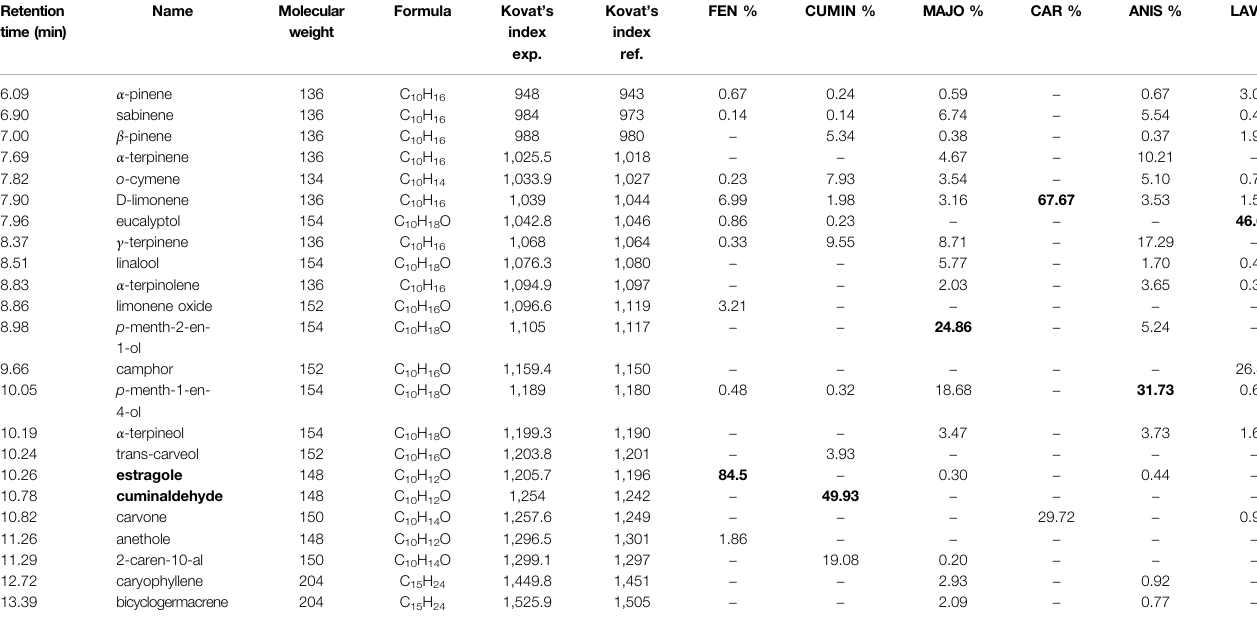
TABLE 4 | GC-MS analysis of volatile